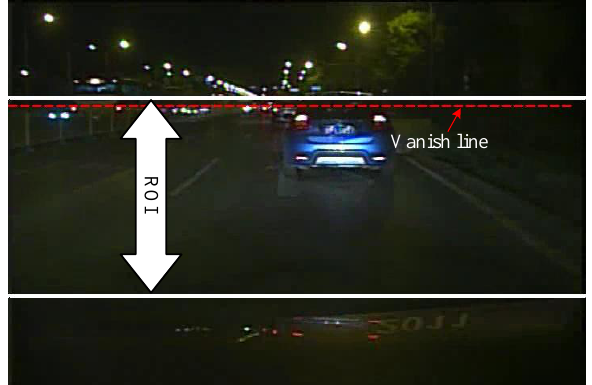
Figure 1. Region of Interest (ROI) of a typical image of a nighttime traffic